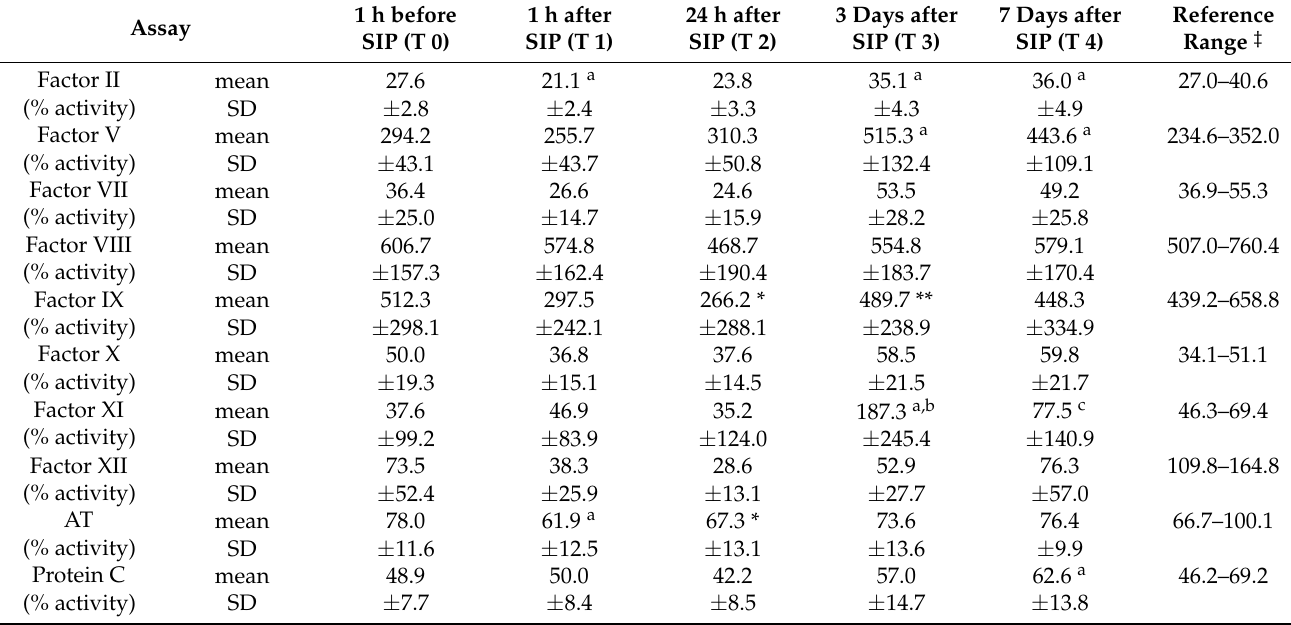
Table 3. Coagulation activators (factors II–XII) and inhibitors (AT and protein C) in the experimental sheep. Data are expressed as means and ± standard deviations